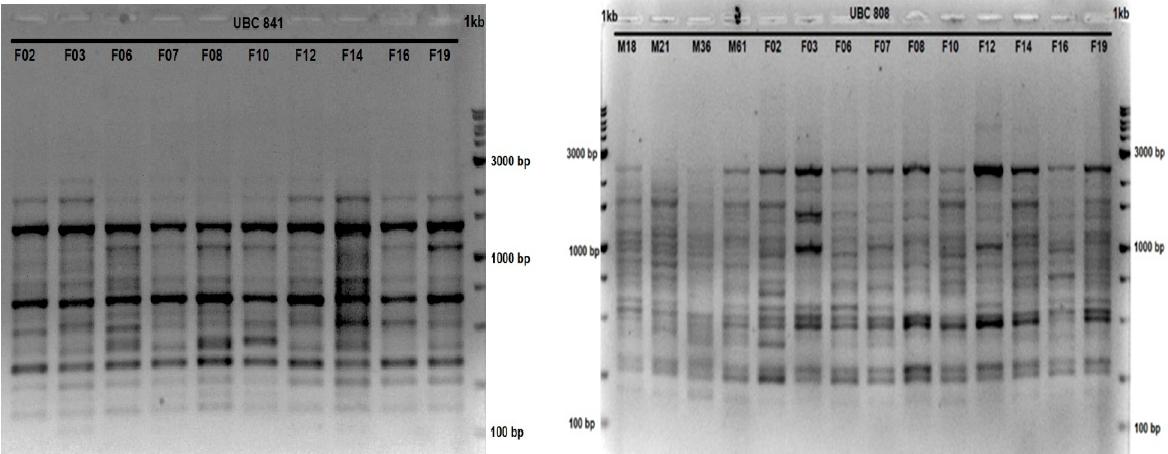
Figure 8. Representative gel electrophoretic pattern of the amplification reactions performed using DNA from P. lentiscus var. Chia genotypes (F2 to F19 and M18 to F19) and primers UBC 841 and UBC 808. The size of the amplified zones was calculated using 1kb DNA ladder plus.